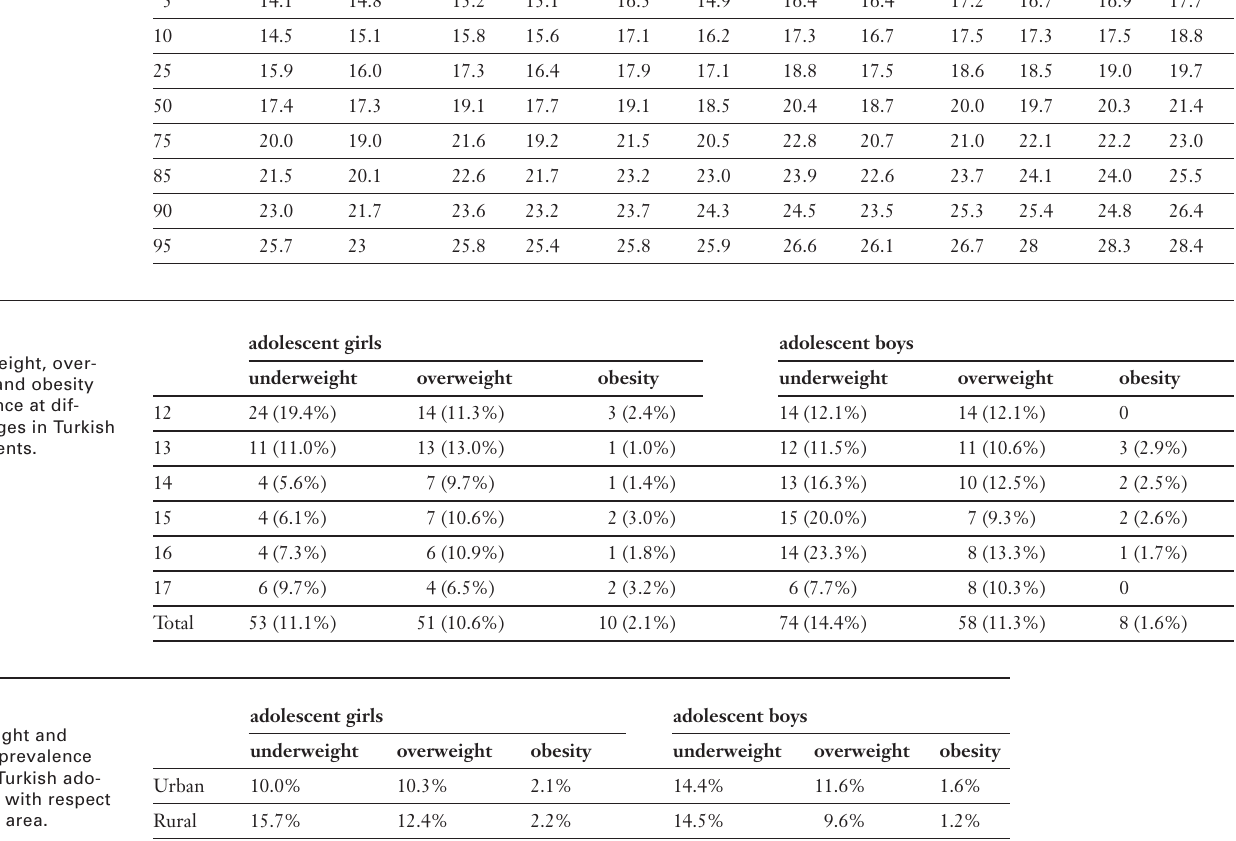
Table 2 Crude percentiles for BMI (kilograms per square meter) in our subjects.